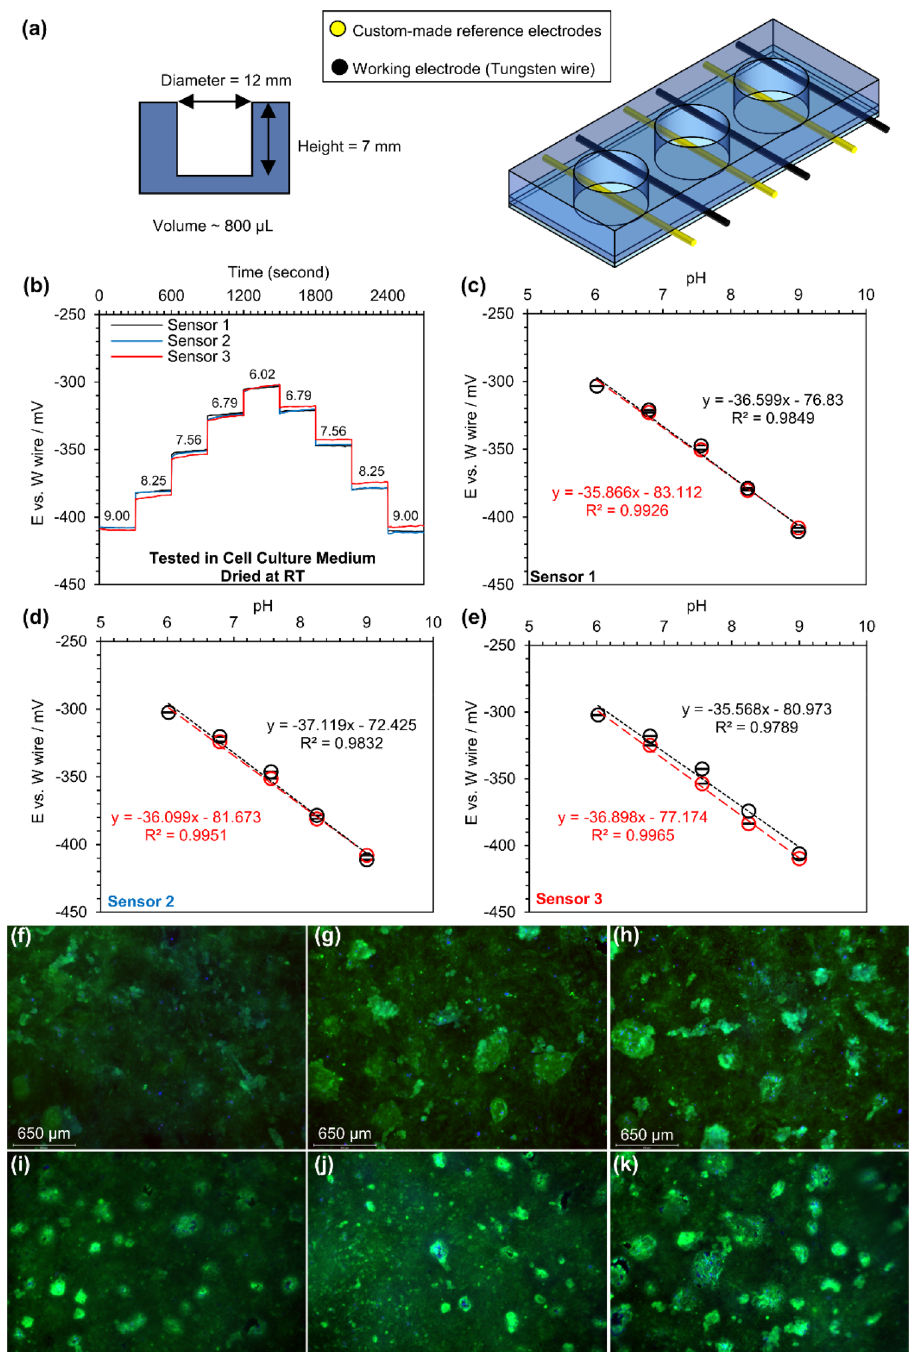
Figure 6. In vitro studies of wire format sensors placed in an array of macro wells: ( a ) the schematic and dimensions of macro wells, ( b ) real-time response of 5-min bleached silver wires versus a tungsten wire in cell culture medium without bicarbonate and adjusted pH after being conditioned in PBS for 1 day, ( c – e ) the calibration curves for each sensor, ( f – h ) in vitro viability assay of Calu-3 cells cultured in PDMS macro wells without the present of wire sensors, and ( i – k ) in vitro viability assay of Calu-3 cells cultured in PDMS macro wells with the present of wire sensors. N = 3. Red colors show the decrease in pH, and the increase in pH is shown in black